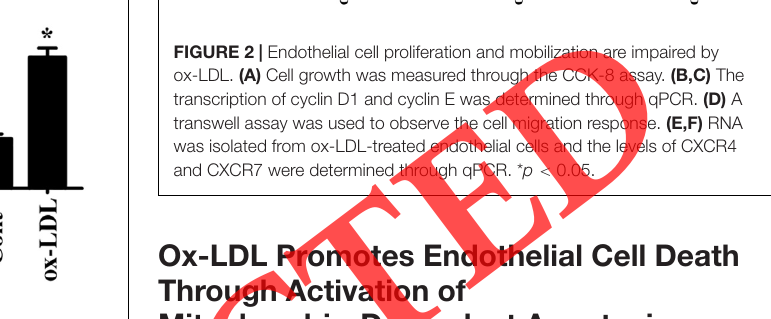
FIGURE 1 | Ox-LDL represses endothelial cell viability and promotes death. (A) An MTT assay was used to observe cell viability in response to ox-LDL treatment. (B,C) TUNEL staining was applied to observe the number of TUNEL-positive cells in response to ox-LDL treatment. (D) An ELISA was used to determine caspase-3 activity in endothelial cells. * p < 0.05.